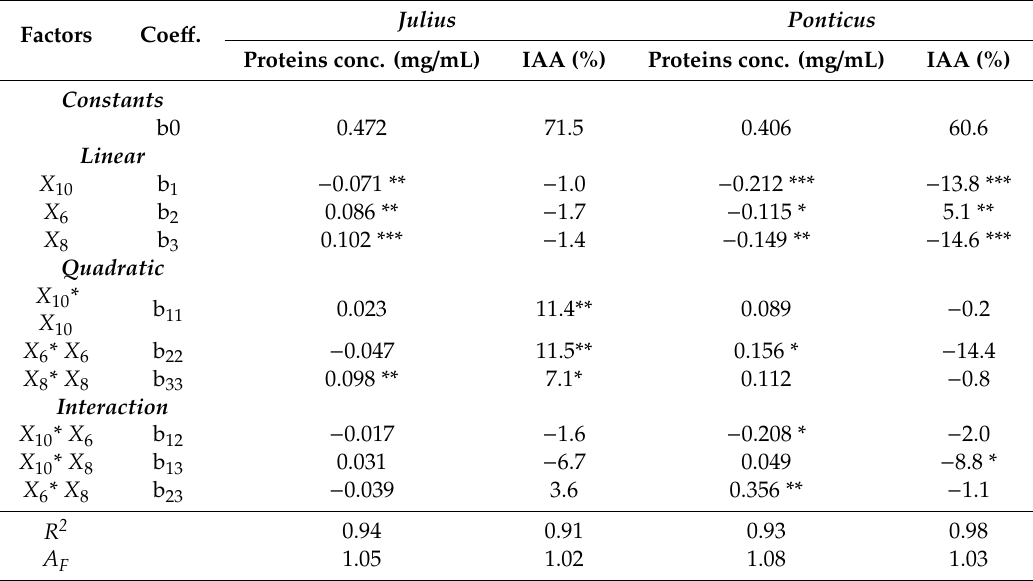
Table 3. Factor coefficients estimated after analysis of Doehlert design and their corresponding R 2 and A F . Julius Ponticus Factors Coe ff . Proteins conc. (mg /